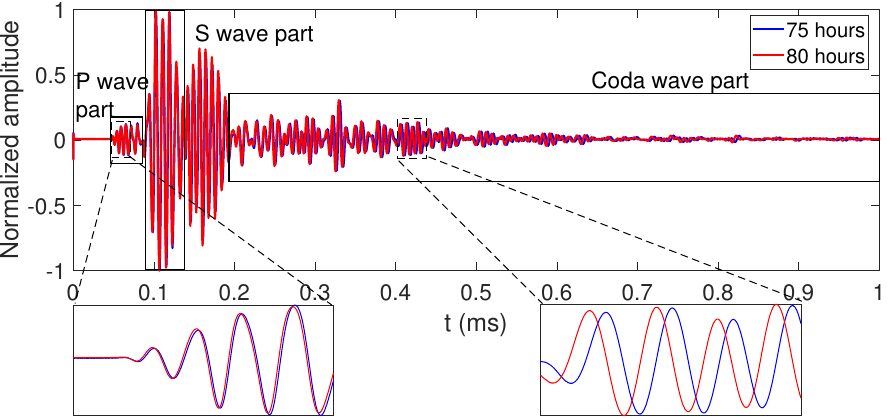
Figure 3. Two ultrasonic signals recorded at ages of 75 and 80 h. The insets show large time shift in the coda